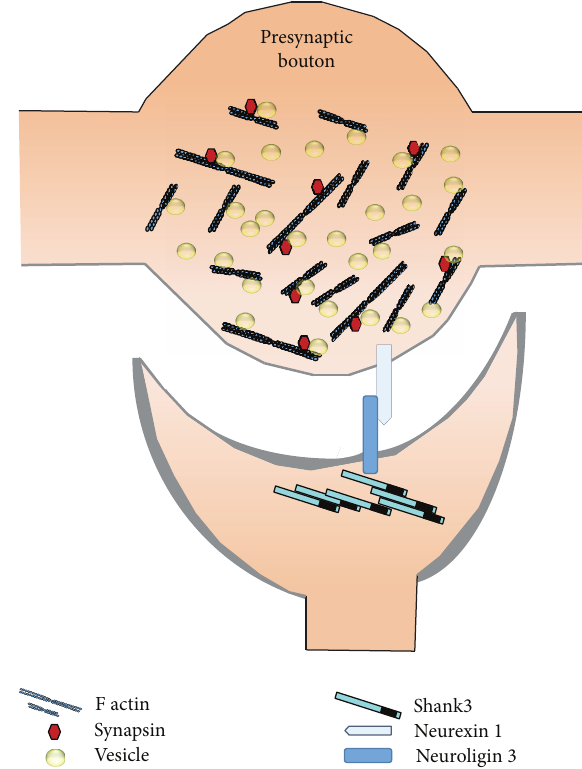
Figure 2: Actin in the presynaptic bouton. Actin performs a crucial role in the vesicle trafficking, starting from docking of the vesicle to neurotransmitter release. A special actin binding protein, synapsin, assists actin in this regard. Synapsin can bind with filamentous actin, and together they provide the supportive network for vesicle release. Shank3 can bind with the C-terminal tail of neuroligin 3 and thereby is able to modify the presynaptic signaling via transsynaptic neuroligin-neurexin pathways. Synaptic activity increases the amount of Shank3 in the PSD, which leads to a coordinated increase in presynaptic synapsin. Further, during neuronal development, Shank3 can also be located presynaptically, thereby directly influencing actin dynamics